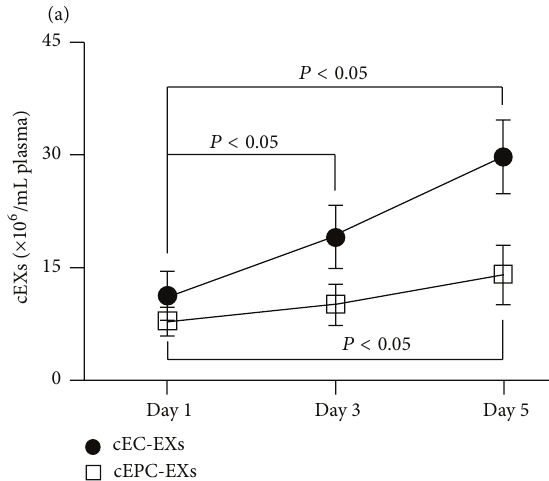
Figure 7: The dynamic change of cEC-EXs and cEPC-EXs in stroke patient plasma on days 1, 3, and 5 after admission. (a) The dynamic change of cEC-EXs and cEPC-EXs per mL plasma on days 1, 3, and 5 after stroke patient admission upon analysis by